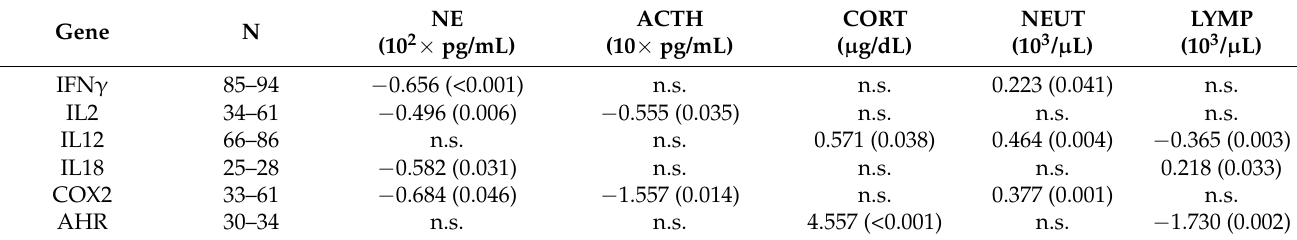
Table 2. Significant associations ( p < 0.05) of blood parameters with normalized averaged cycle quantification values ( ∆ Cq) reported as estimates of fixed effects using a Linear Mixed Model (LMM) Analysis with repeated measures for T/NEnv, OWE and WLCR studies. The number of samples that are included in the model for each gene is indicated as a range (N), and p -values for each significant association are indicated in parentheses. Positive values indicate increasing gene expression with increasing blood parameter concentrations (i.e., positive relationship), while negative values indicate decreasing gene expression with increasing concentrations or vice versa (i.e., negative